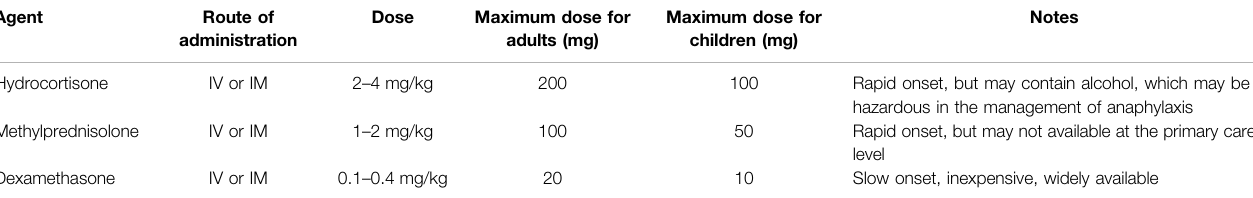
TABLE 5 | Dosage and administration of corticosteroid